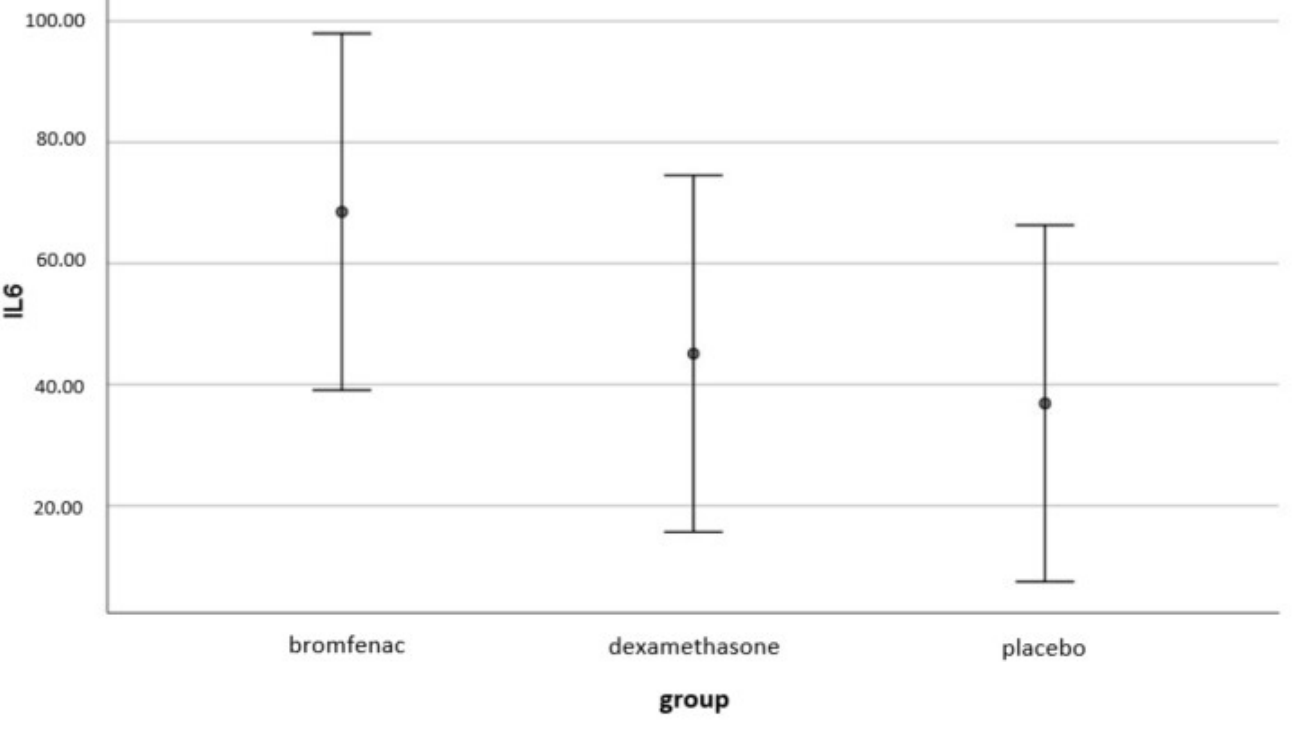
Figure 5. Difference in IL-6 concentration (pg/mL) between the groups was not statistically significant ( F (2, 87) = 1.227, p < 0.298); bromfenac group n = 30; dexamethasone group n = 30; placebo group n = 30. 4.4. Differences in Age and in DM Duration (Risk Factors for PCME) There were no statistically significant differences in age or DM duration between the